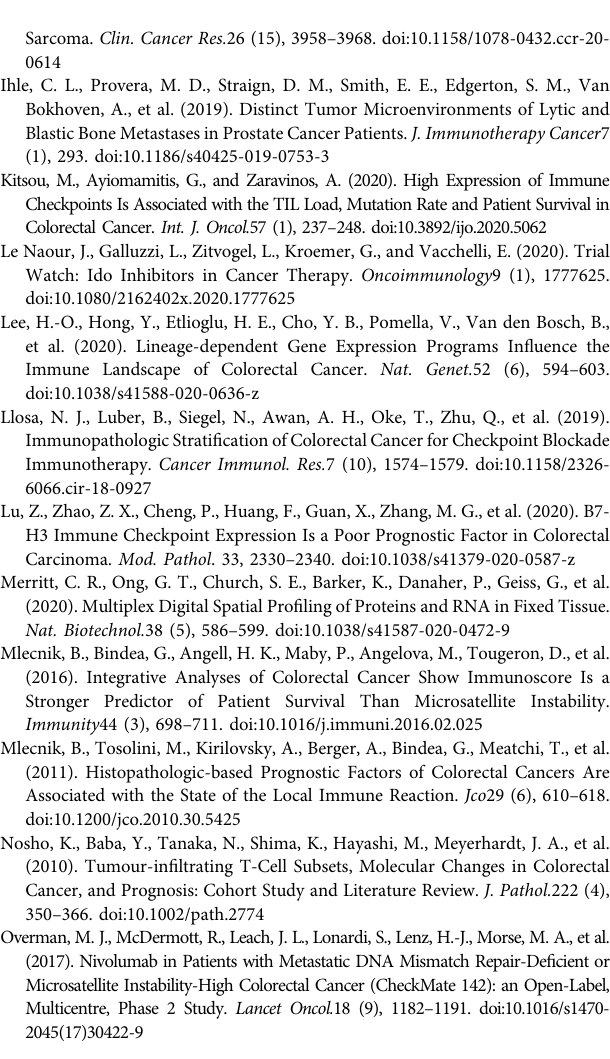
Supplementary Table 1 | Patient clinical information. Supplementary Table 2 | DSP probe list for mRNA. Supplementary Table 3 | DSP probe list for